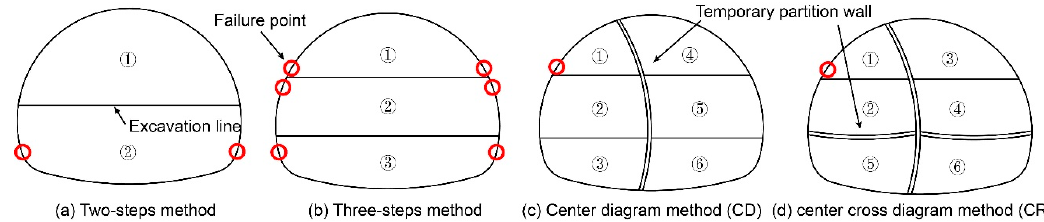
Figure 3. Common construction methods of loess tunnel: ( a ) The two-steps method; ( b ) The three-steps method; ( c ) The center diagram method (CD); ( d ) The center cross diagram method (CRD). Table 2. Statistics of construction methods and surrounding rock failure points of shallow buried loess